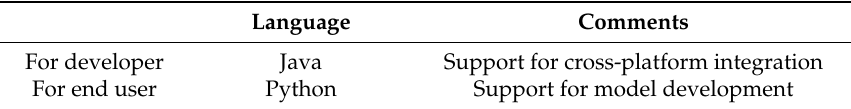
Table 1. Development languages in proposed multidiscipline integrated platform.